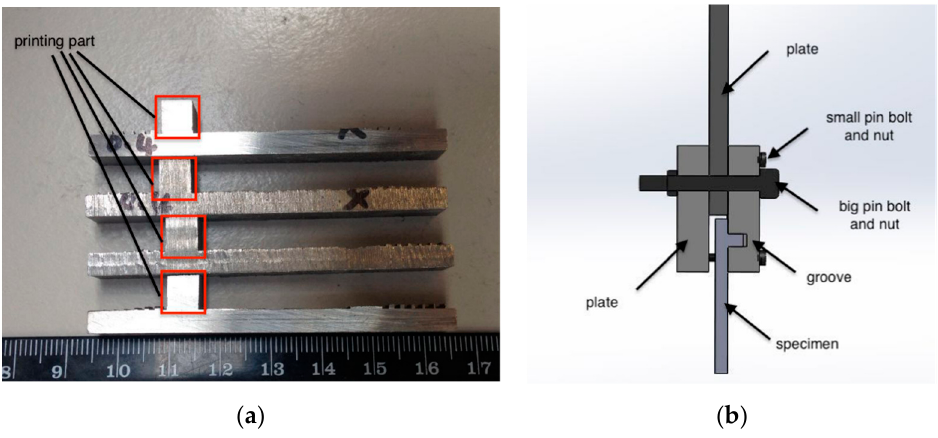
Figure 3. ( a ) Samples for shear testing and ( b ) the corresponding grip.